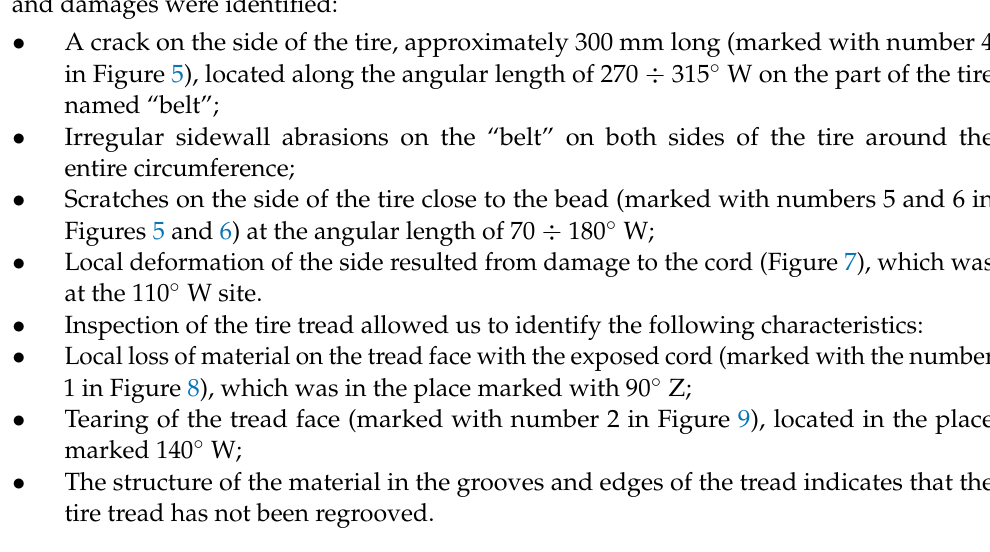
Figure 5. View of the inside of the tire of the left front wheel of a truck tractor.